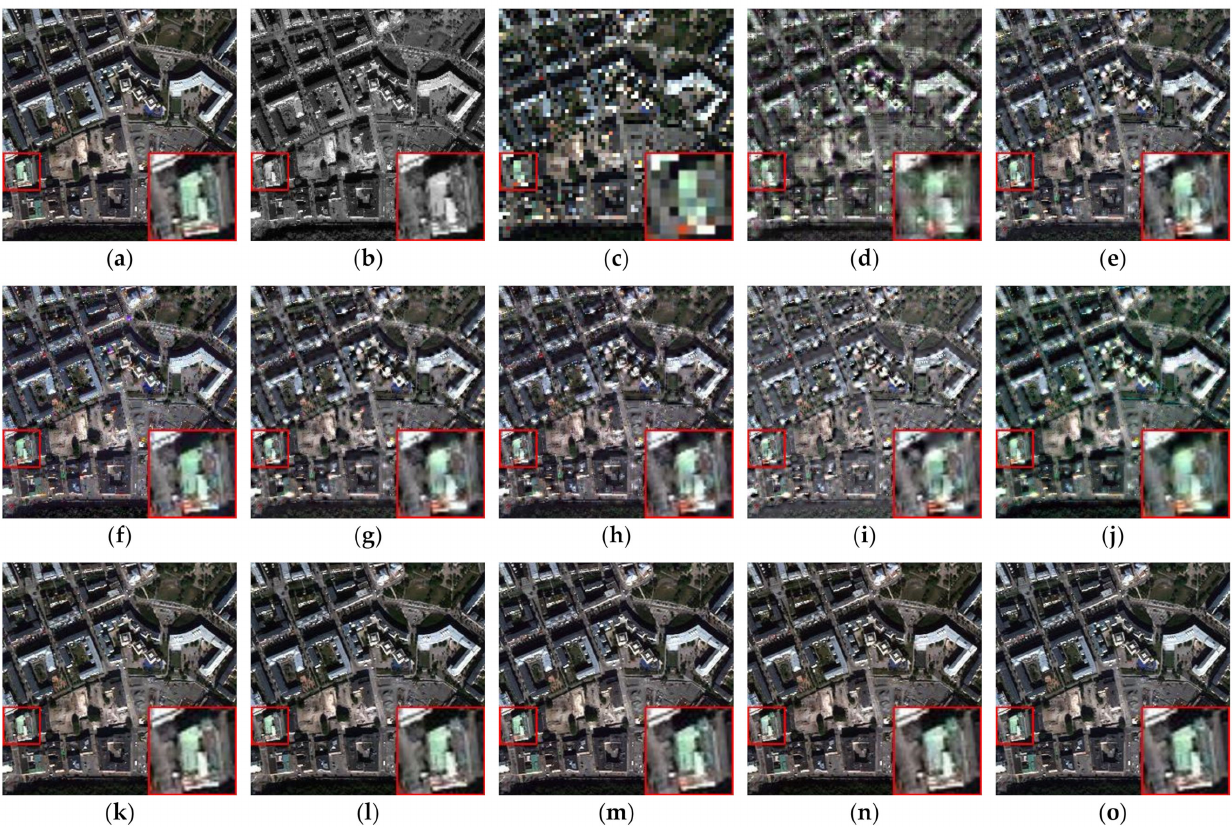
Figure 11. Results for four bands using the QuickBird dataset (resolution, 256 × 256 pixels): ( a ) ref- erence image; ( b ) PAN; ( c ) LRMS; ( d ) DWT; ( e ) HPF; ( f ) GS; ( g ) GLP; ( h ) SFIM; ( i ) IND; ( j ) PRACS; ( k ) DMDNet; ( l ) CPNet; ( m ) TPNwFB; ( n ) TDPNet; ( o ) ours